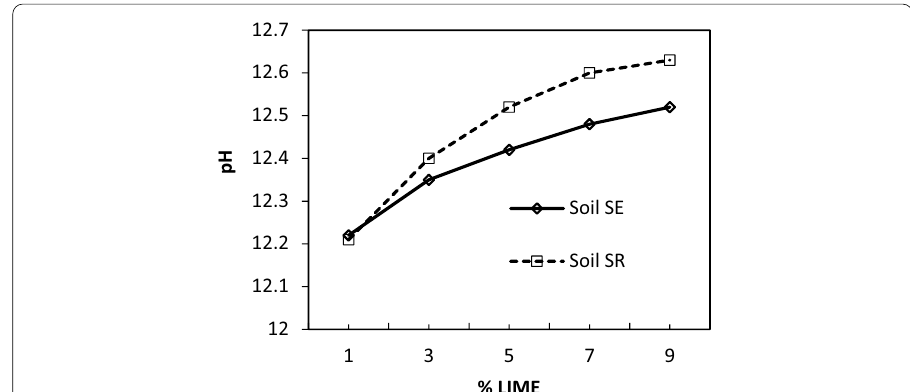
Fig. 2 pH of soil SE and SR at different lime content